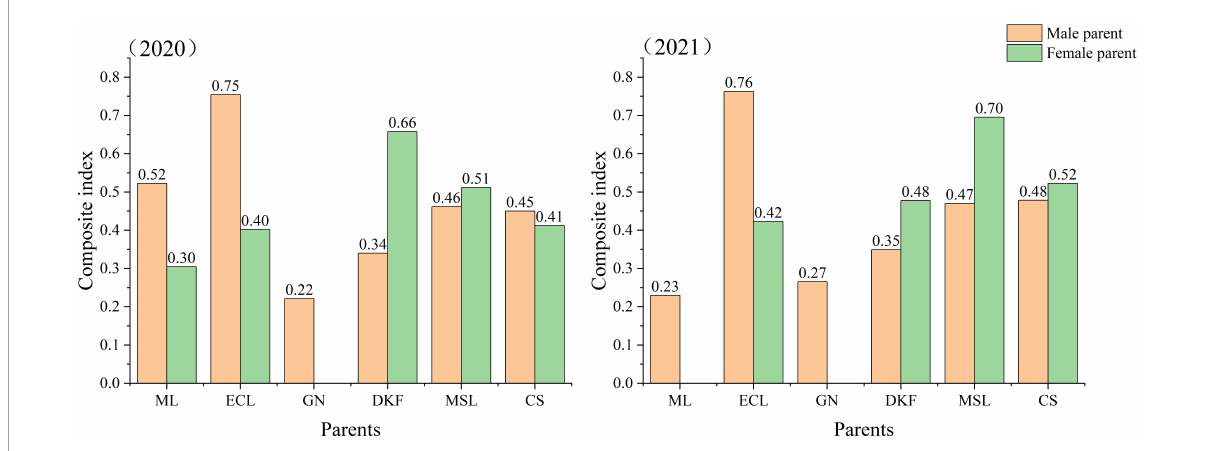
FIGURE4 The comprehensive index of fertility of the tested parents as male or female parents in 2020–2021. Note: ML, ECL, GN, DKF, MSL, and CS represent cultivars of Meili, Ecolly, Garanior, Dunkelfelder, Marselan, and Cabernet Sauvignon. Since the flowering period of GN began first, in the experiment at the same site, GN could only be selected as a hybrid male parent. In 2021, the hybrid combination with ML as the female parent hardly harvested full seeds, which may be related to the premature emasculation. In order not to affect the authenticity of the overall results, the crosses with ML as the female parent were excluded from the analysis.